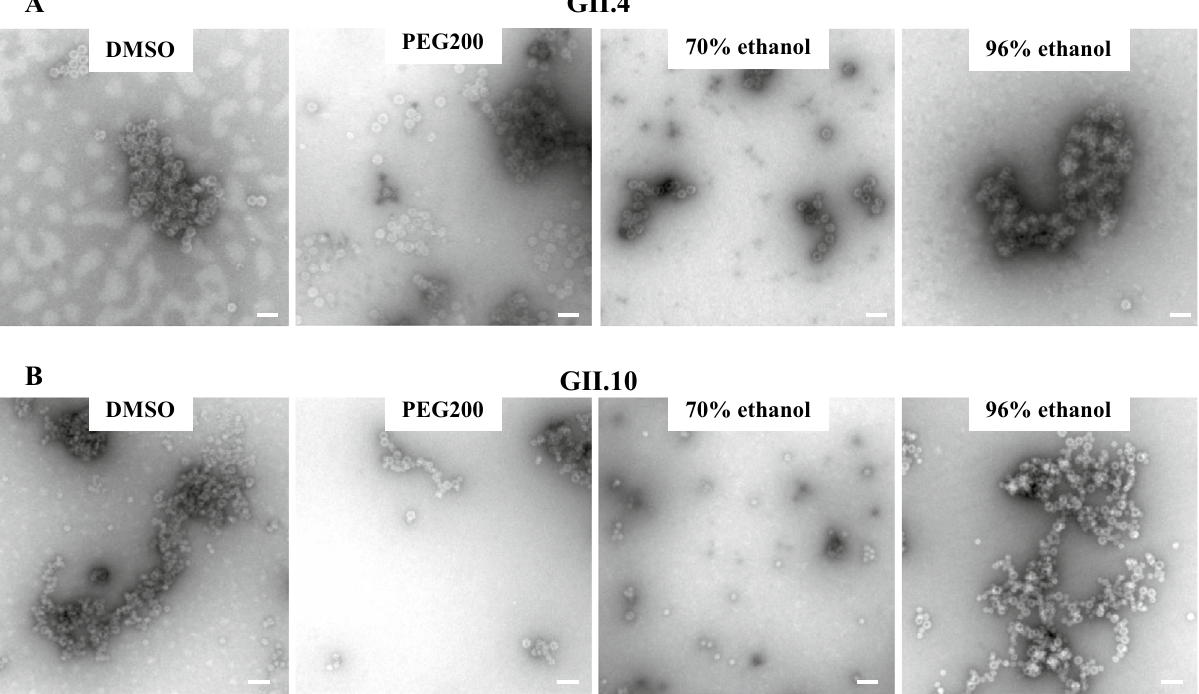
Figure 9. Propolis and EM analysis of GII.4 and GII.10 VLPs. Negative stain EM was used to directly determine the integrity of the VLPs. For both ( A ) GII.4 and ( B ) GII.10 VLPs, treatment with 100% DMSO propolis, 96% ethanol propolis, and 20% PEG200 propolis (final concentration of propolis 12.5%, final concentration of solvents DMSO 12.5%, PEG200 2.5%, 70%-ethanol 8.75%, and 90%-ethanol 12%) resulted in VLP aggregates, whereas mainly single VLPs were observed with 70% ethanol propolis. Scale bar = 100 nm. EM analysis was performed in triplicate and representative images of the samples were presented.